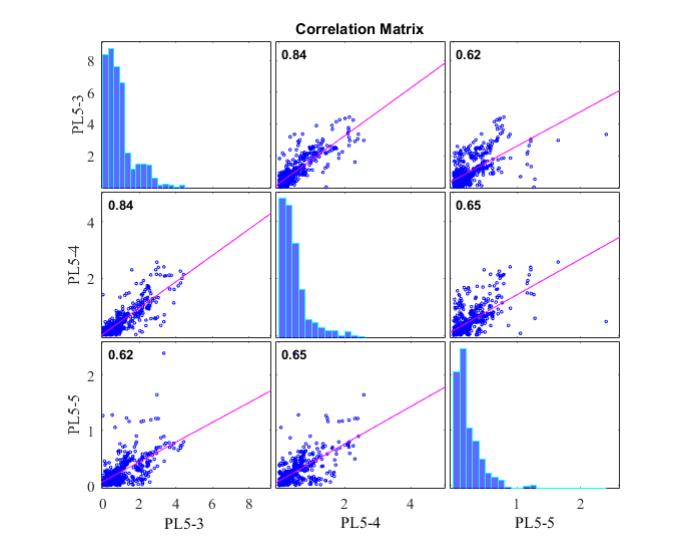
Figure 9. Pearson correlation coefficient r between | ε | 9 − 3 , | ε | 9 − 4 and | ε | 9 − 5